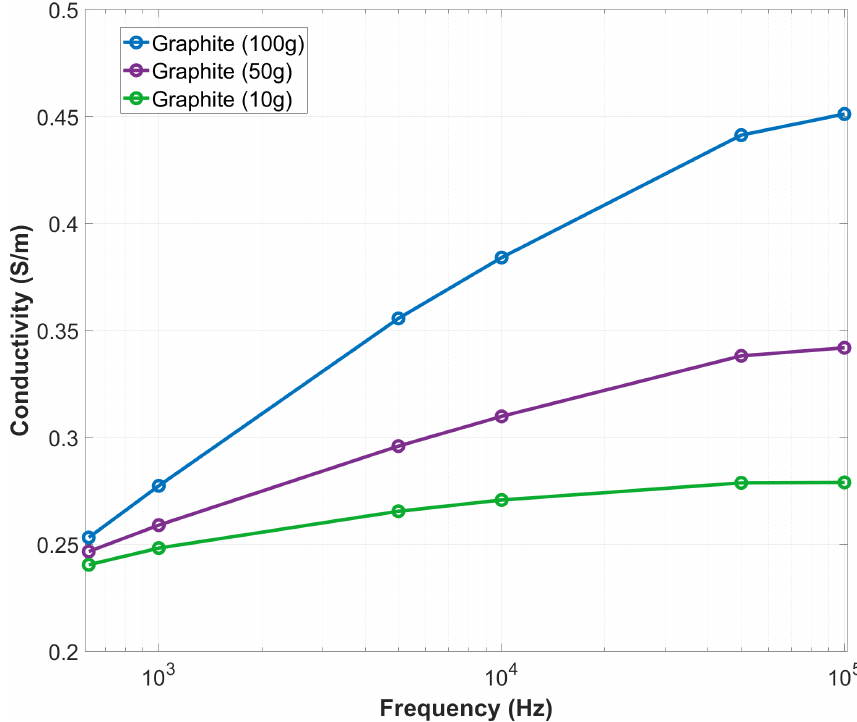
Figure 5. The conductivity spectra of three graphite-agar phantoms with various concentrations of graphite added: 10 g, 50 g, and 100